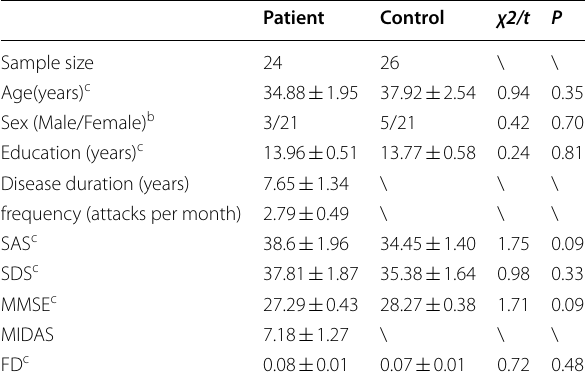
Table 1 Demographics and scales of migraine patient